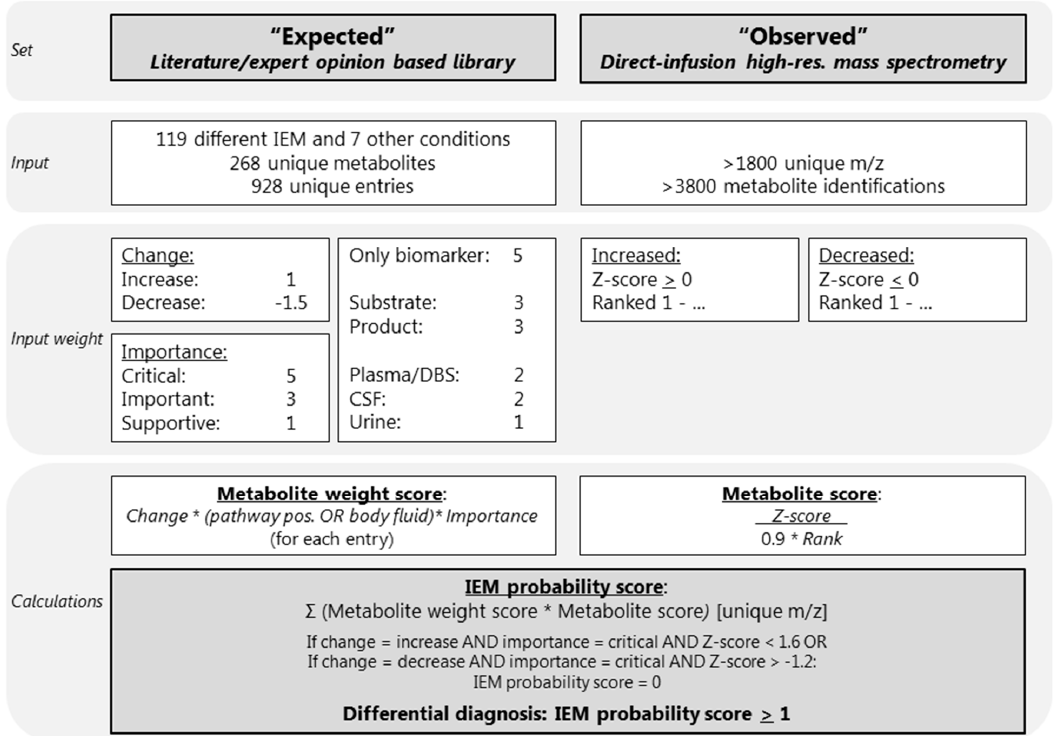
Figure 1. Overview of the diagnostic algorithm. CSF: cerebrospinal fluid; DBS: dried blood spots; IEM: inborn error of metabolism; m / z: mass to charge ratio. The * indicates multiplication. The Rank (Ranked 1- ... ) is calculated as followed: positive Z -scores were ranked from the maximum Z -score to zero (the highest Z -score observed ranked at position 1), and negative Z -scores were ranked from the minimum Z -score (ranking at 1) to zero. Figure 2. Flowchart of the six phases of the development and optimization of the diagnostic algorithm, with in-between assessments of the performance of the algorithm in the training sets, DBS optimization set and plasma validation set